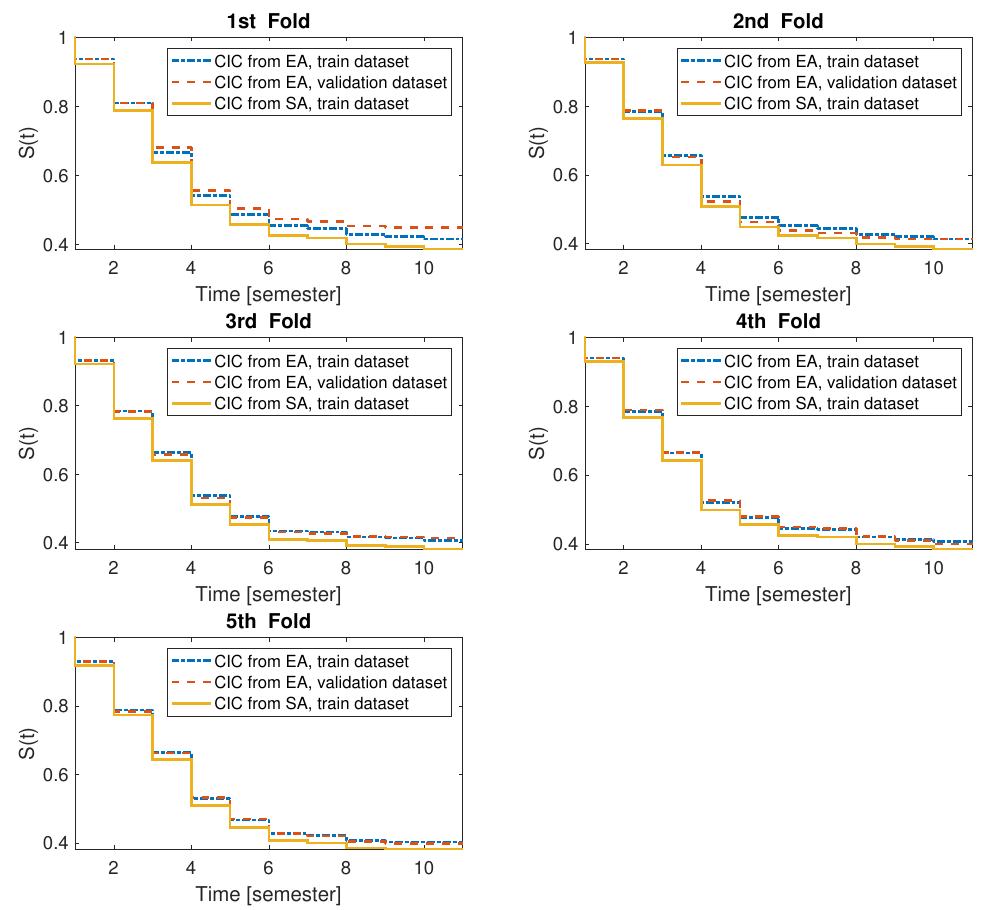
Figure 4. The Cumulative Incidence Curve (CIC) formed from Event Analysis (EA) by association rules (training dataset—blue; validation dataset—red) and Survival Analysis (SA) (green) for non- graduate students. The functions illustrates well that the proposed methodology is able to predict the dropout of a